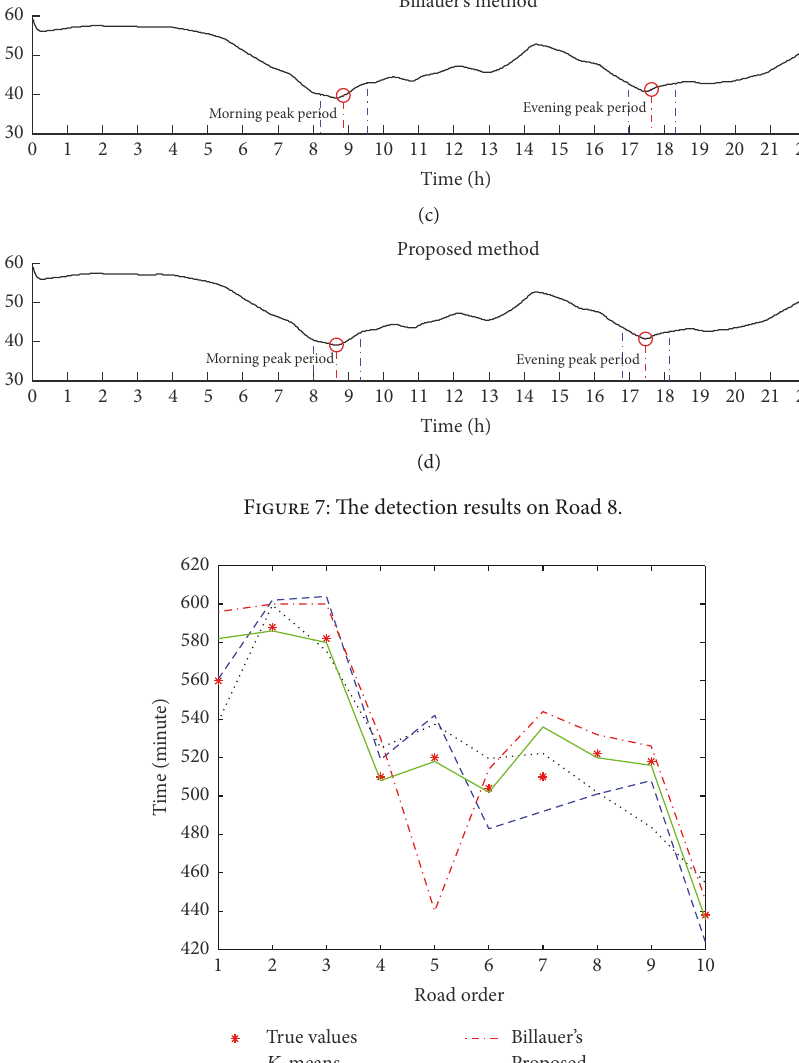
Figure 8: Performance comparison of four methods for morning peak period